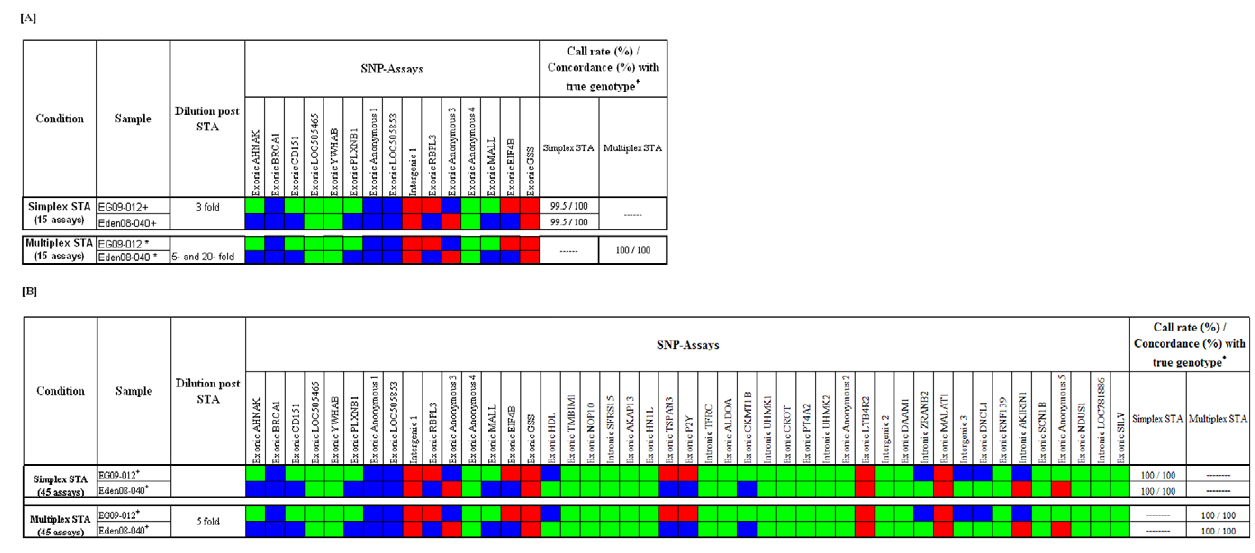
Figure 3. Summary genotype calls obtained for representative whale DNA samples. Genotype calls obtained for representative whale DNA samples extracted using CTAB or Maxwell H tissue extraction kit and following simplex or multiplex STA using either 15 [A] or 45 SNP-GT assays [B]. The genotype call ( pp , qq and pq ) for each reaction are denoted in ‘ red ’, ‘ green ’ and ‘ blue ’, respectively. ‘ + ’ refers to samples extracted using CTAB method; ’*’ refers to each sample extracted using both CTAB and Maxwell H tissue extraction kit; ‘ ¤ ’ refers to concordance with true genotype determined at AAD using an independent method. Note: Regardless of the approach used, genotypes for representative samples using either 15 or 45 SNP-GT assays were the same, as indicated by the same color. Samples EG09-004, EVH09-53, WA07-006 and WA07-003, extracted using CTAB or Maxwell H tissue extraction kit were genotyped using 15 SNP-GT assays with and without STA and showed a 100% call rate and concordance (data not shown).